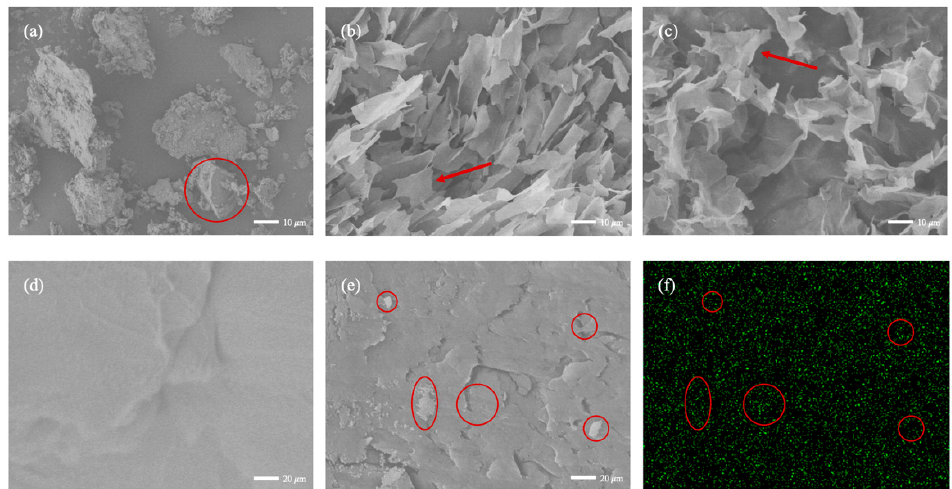
Figure 2. SEM micrograph of ( a ) bulk Ti 3 AlC 2 powder; ( b ) freeze-dried Ti 3 C 2 nanosheets; ( c ) freeze- dried O-Ti 3 C 2 nanosheets; ( d ) PS surface; ( e ) PS/O-Ti 3 C 2 nanocomposite surface; and ( f ) EDS for Ti element mapping on PS/O-Ti 3 C 2 nanocomposite surface.